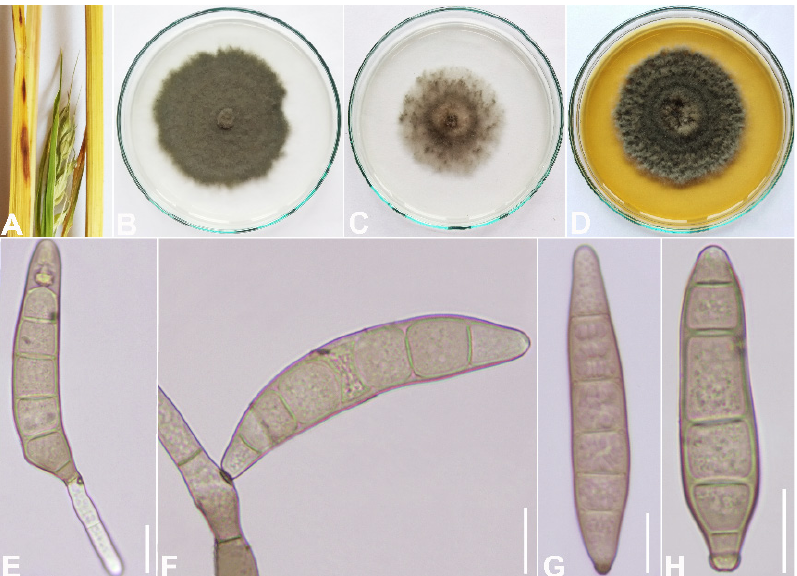
Figure 2: Morphological characters of Exserohilum oryzicola (isolate USJCC–0010). A. lesions on Echinochloa oryzoides . B. 7-d old colony on PDA C. 7-d old colony on CMA D. 7-d old colony on MEA. E. Germinating conidium. F–H. Conidia. (Scale bars: E–H = 10 μm).